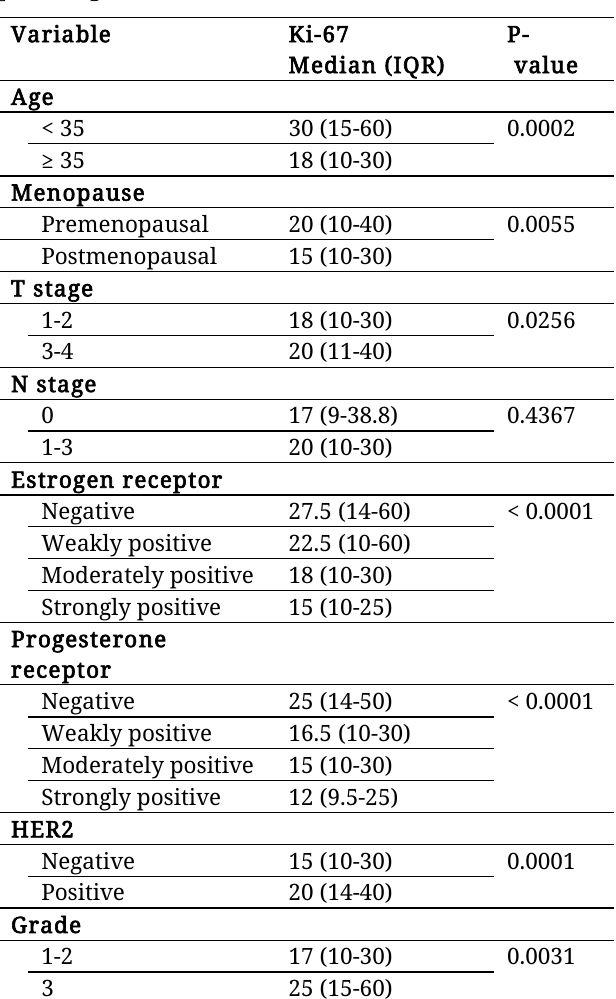
Table 2: Correlation between Ki-67 and clinico- pathological variables